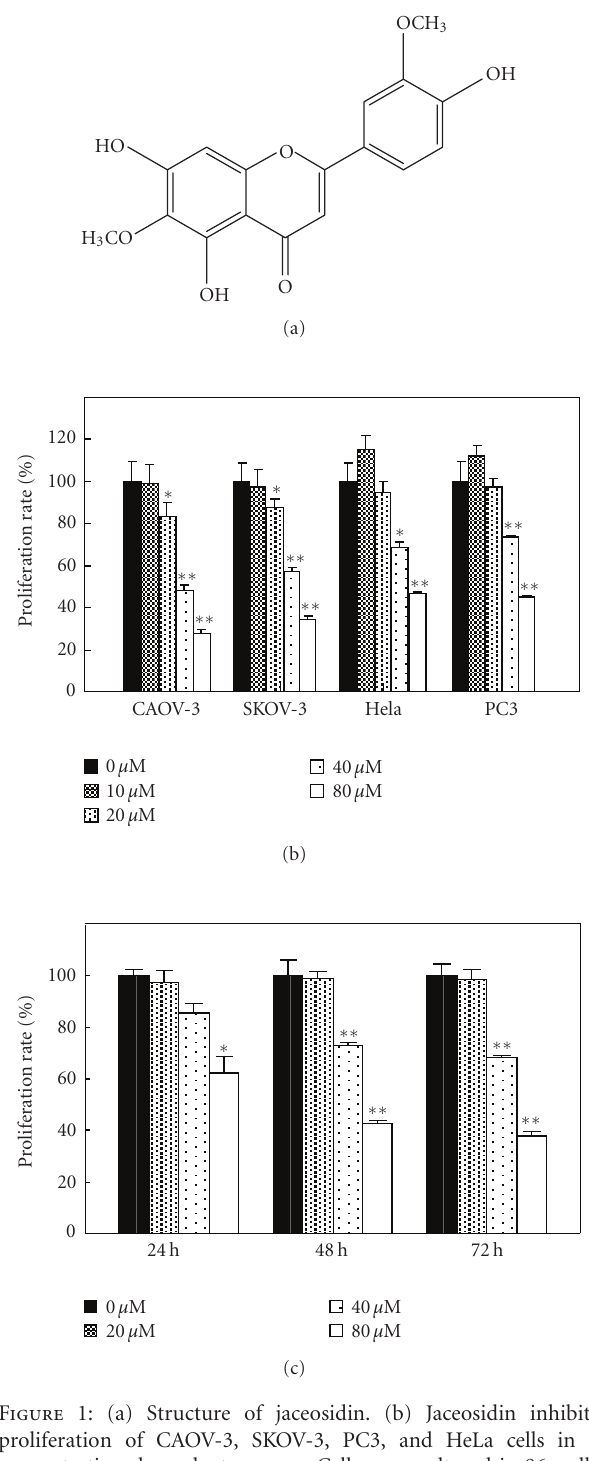
Figure 1: (a) Structure of jaceosidin. (b) Jaceosidin inhibits proliferation of CAOV-3, SKOV-3, PC3, and HeLa cells in a concentration-dependent manner. Cells were cultured in 96-well- plate for first 24 hours. Then, they were treated with di ff erent concentrations of jaceosidin for further 48 hours. (c) Jaceosidin inhibits proliferation in CAOV-3 cells in a time-dependent manner. The CAOV-3 cells were incubated with jaceosidin for 24, 48, and 72 hours, respectively. MTT assay was used to evaluate the proliferation rate. Each datum indicated mean ± s.d. of three independent experiments. ∗ P < . 05, ∗∗ P < . 01 versus control (Dunnett’s